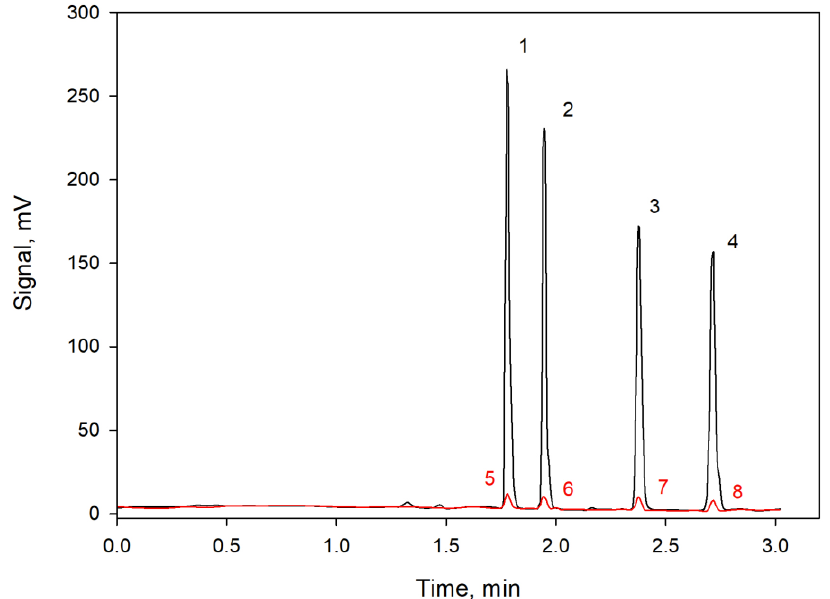
Figure 5. Gas chromatograms obtained with capillary GC column used for the determination of n-hexane (1, 5), benzene (2, 6), n-heptane (3, 7) and toluene (4, 8) in a model solution after preconcentration via selective adsorption of the gas-extractant (1, 2, 3, 4) and without it (5, 6, 7, 8). Concentrations of n-hexane and n-heptane—0.2 mg/L; benzene and toluene—5 mg/L. CO 2 flow rate—30 mL/min, time—2 min. Fused silica column with dimethylpolysiloxane coating. In HSA, the dependences of peak area on the concentration of analytes present linear plots with zero intercepts (Figure 6). As for dynamic HSA combined with capillary GC application, the calculated limits of detection (LODs), according to the 3 σ rule, are 0.5 (0.05) µ g/L for benzene, 0.6 (0.06) µ g/L for toluene, 0.030 µ g/L for n-hexane, and 0.035 µ g/L for n-heptane. The values in brackets are approximate values for the mass spectrometry detector (MSD). According to the literature, when MSD was used in the case of benzene, the LOD was 0.2 µ g / L for static HSA [34]; for HS-SPME, 0.04 µ g/L [9]; and for P&T, 0.06 µ g/L [9]. Thus, the sensitivity of the proposed method is not inferior to the